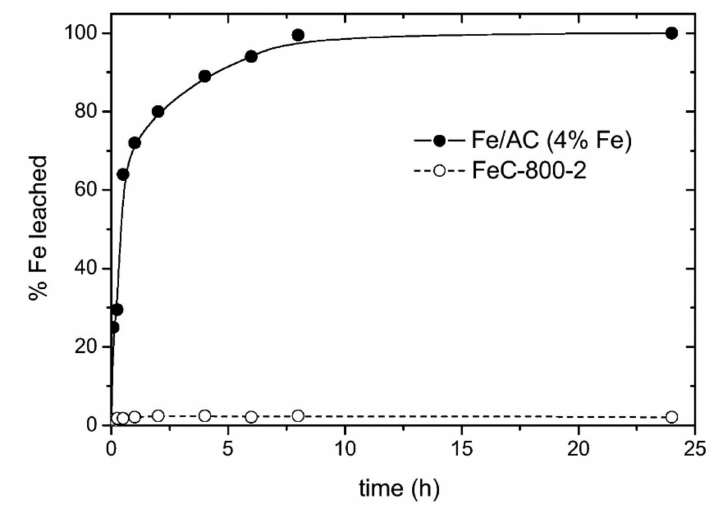
Figure 12. Scheme of FeCl 3 activation and main characteristics of the resulting activated carbons.